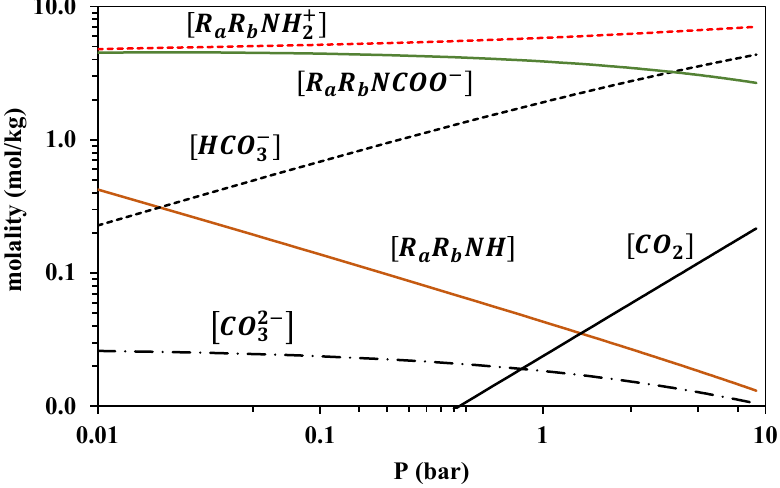
Figure 13. Liquid-phase speciation for MAPA-CO 2 -H 2 O system at 313 K, predicted using modified the Kent-Eisenberg model (calculations performed for the CO 2 loading of 30.0% wt. MAPA aqueous solutions).